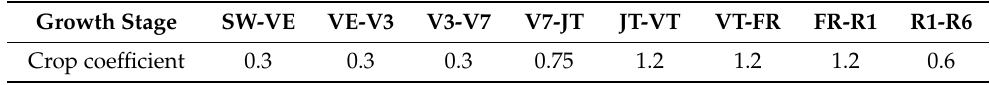
Table 2. Crop coefficients in different growth stages of maize. Growth Stage